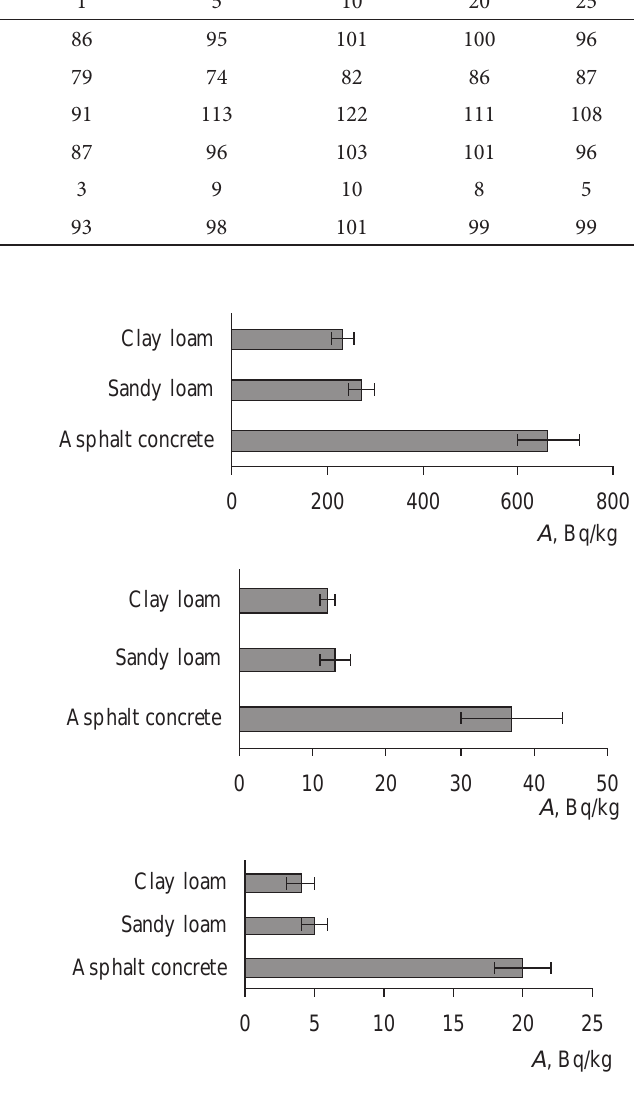
Fig. 5. A , becquerel for kilogram (Bq/kg) of main natural radionuclides 40 K , 226 Ra and 232 Th measured in soil and